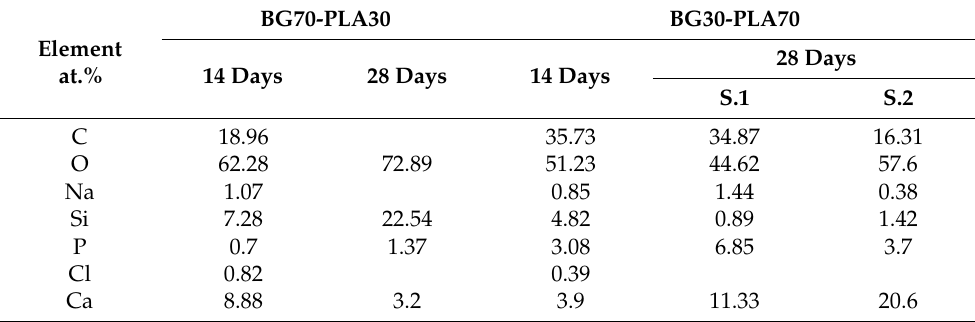
Figure 12. Scaffold SEM analysis for BG30-PLA70 after ( a ) 14 days and ( b ) 28 days of immersion in PBS. Table 6. EDS chemical analysis for BG-PLA composites after immersion in PBS. Element at.%